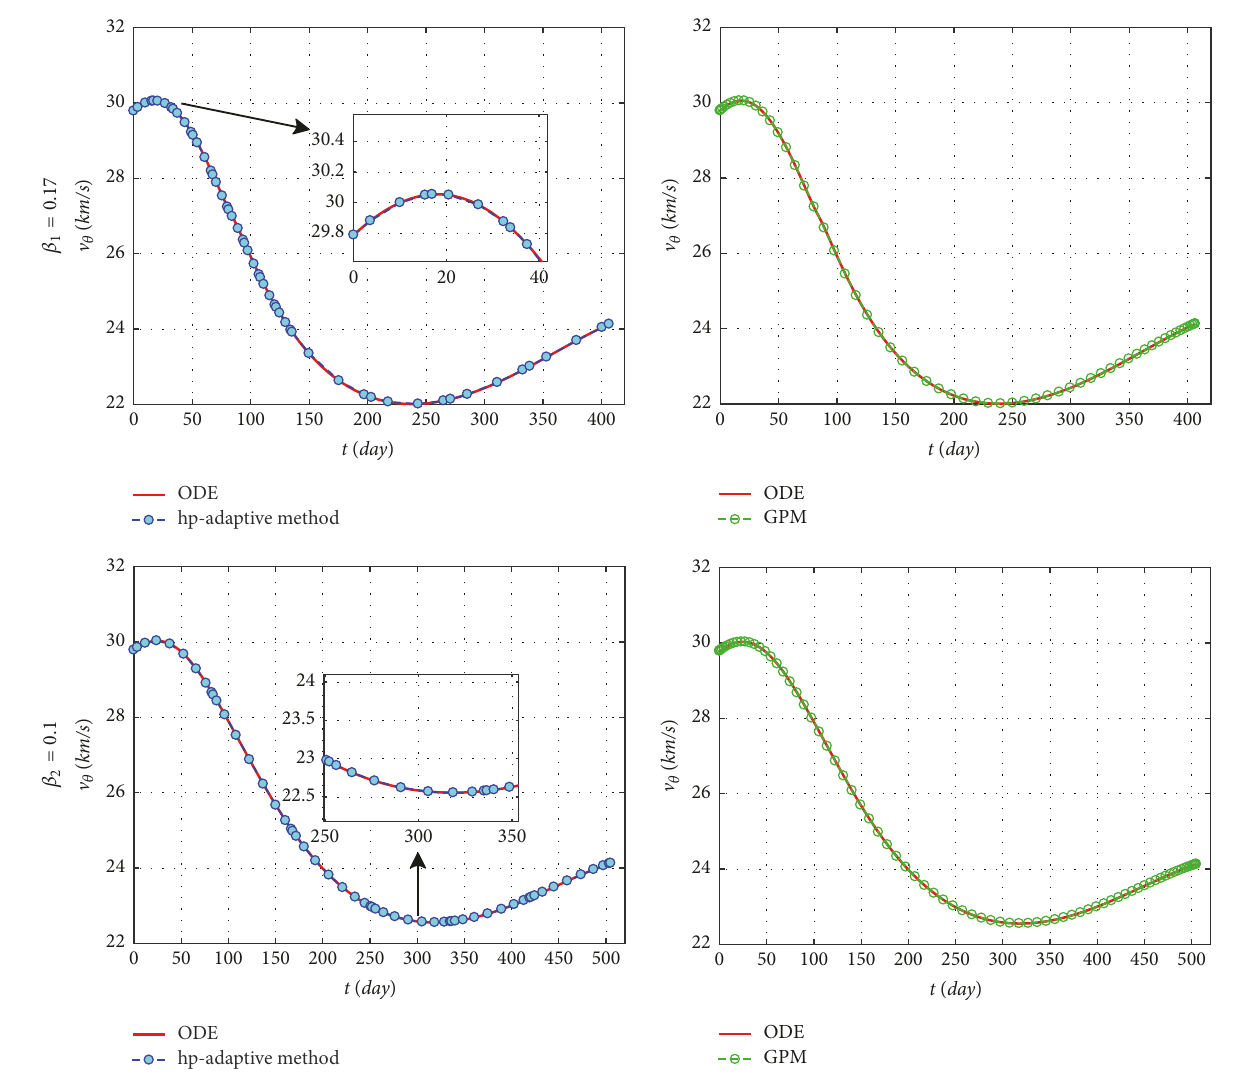
Figure 8: The tangential velocity of transfer